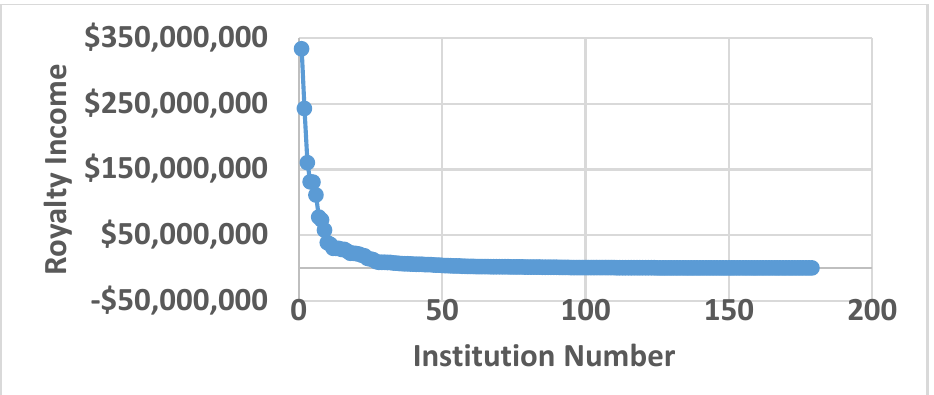
Figure 2. The fiscal year 2016 Association of University Technology Managers (AUTM) data.